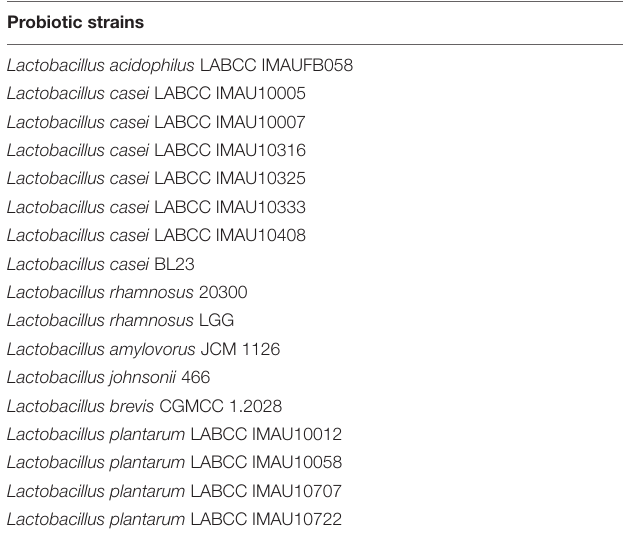
TABLE 1 | List of probiotic